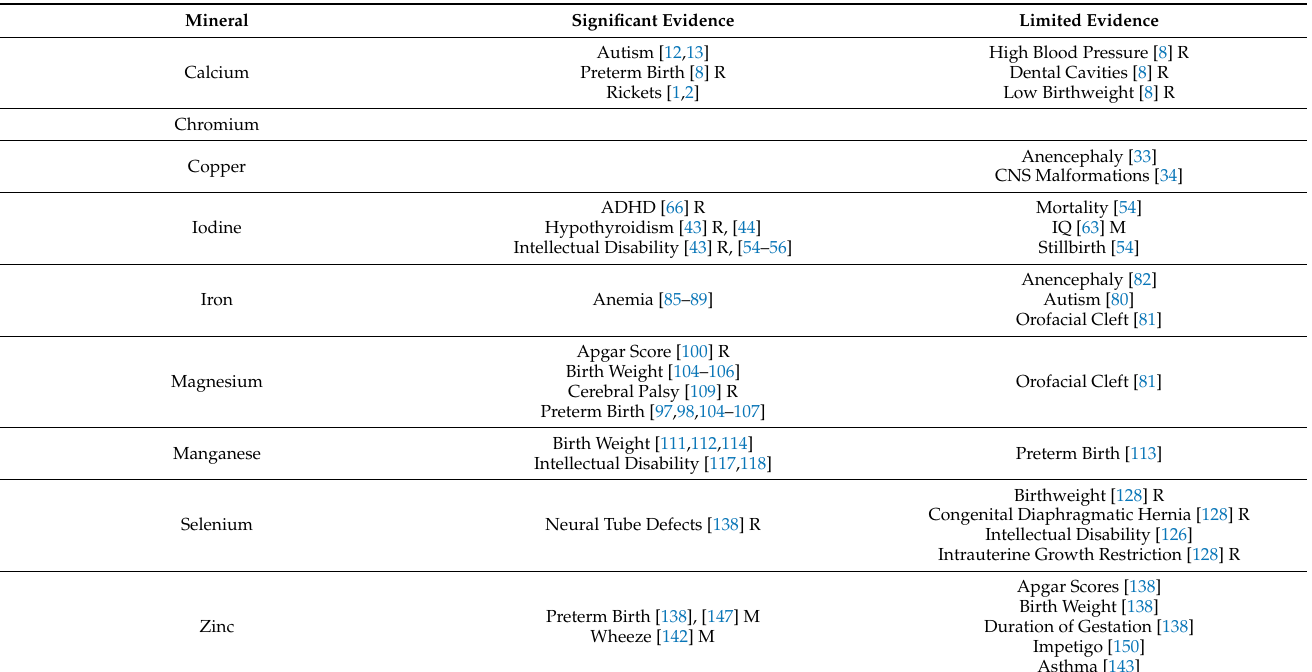
Table 4. Relationship of maternal mineral status to infant health problems/benefits